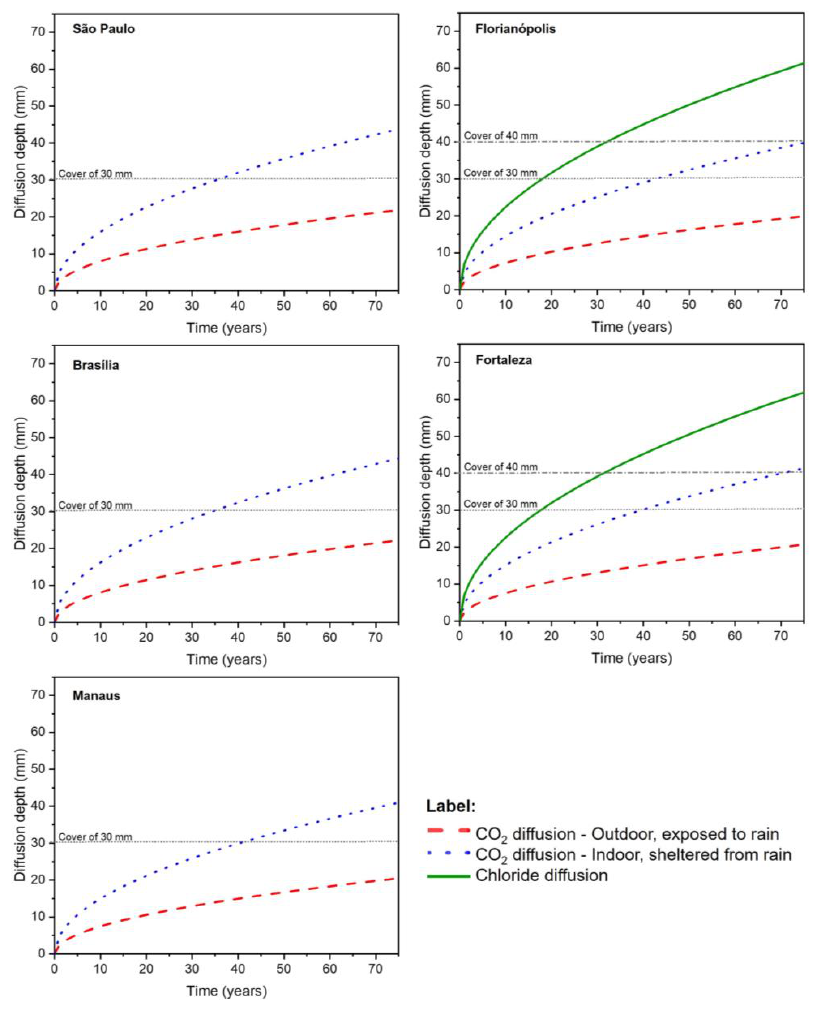
Figure 6. CO 2 and chloride diffusion depth for the simulated scenarios.